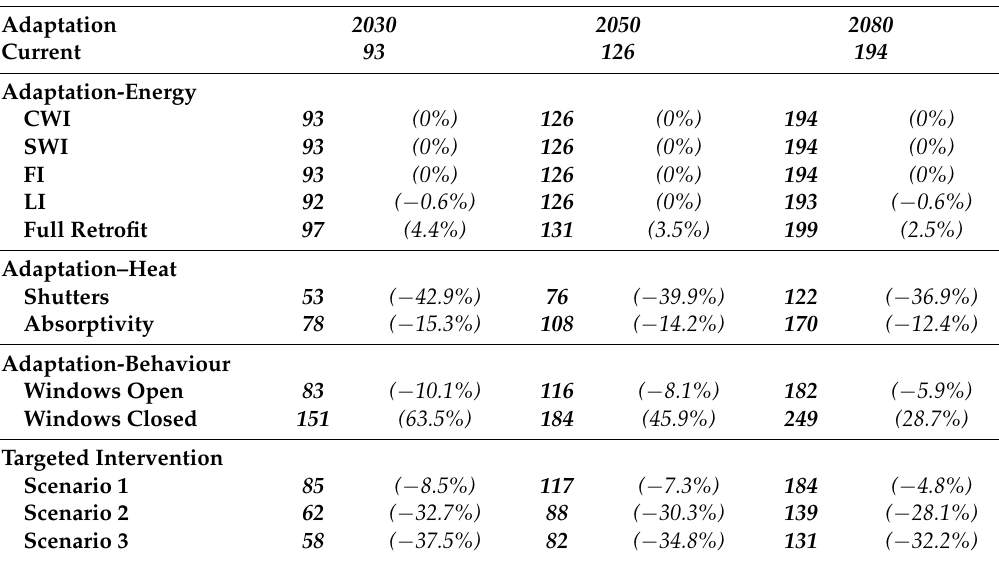
Table 3. The estimated heat-related mortality per million population in the West Midlands prior to and following